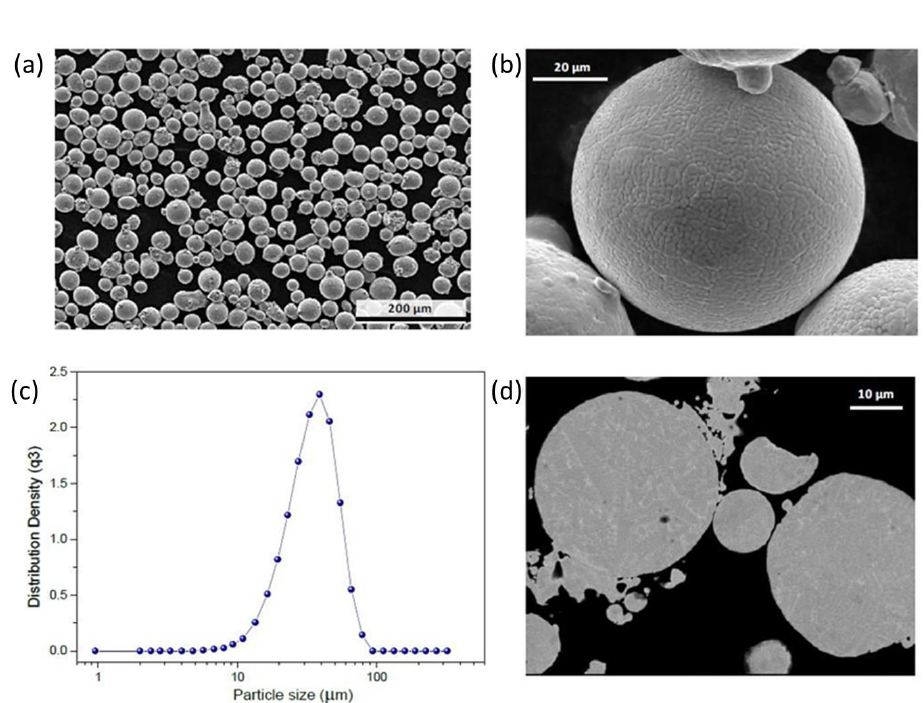
Figure 2. ( a ) IN718 EOS powder circularity, ( b ) Roughness of the powder particle, ( c ) Particle size distribution, ( d ) Backscattered image from the cross-section of the IN718 powder.